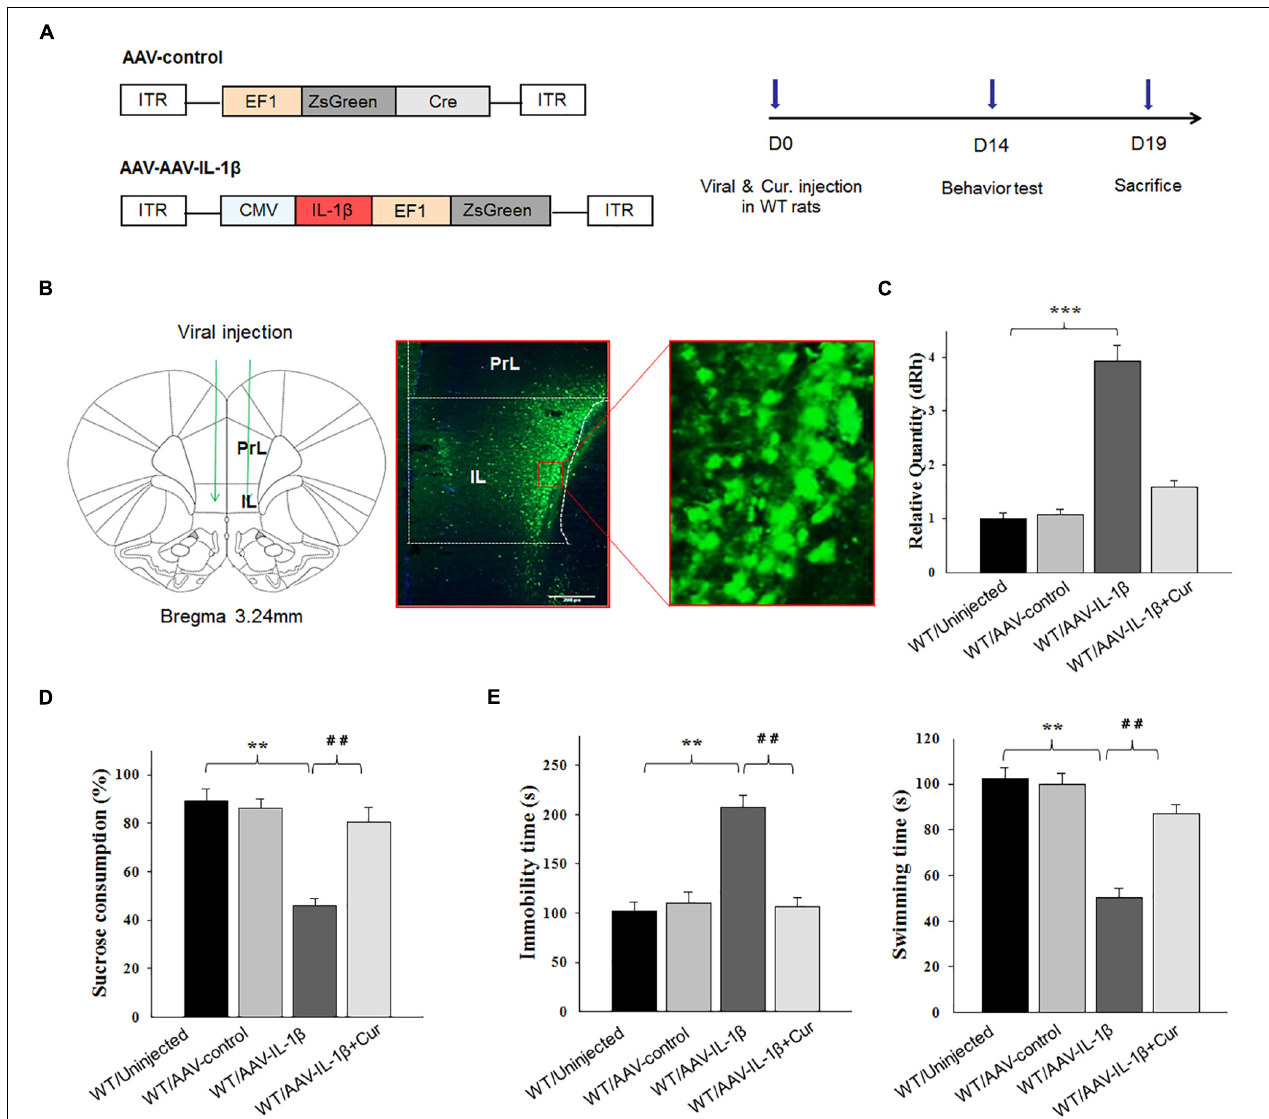
FIGURE 4 | Overexpression of IL-1 β within the vmPFC leads to depression-like phenotypes in normal wild type rats. (A) Left: Schematics of AAV vectors engineered to overexpress a control construct or IL-1 β . ITR, inverted terminal repeats; EF1, ZsGreen promoter; CMV, IL-1 β promoter. Right: Experimental paradigm for behavioral biochemical testing of rats infected with the virus. (B) Illustration of viral infusion of AAV-IL-1 β into the vmPFC. PrL, prelimbic cortex; IL, infralimbic cortex. Scale bar is 100 µ m. (C) Estimation of β CaMKII overexpression efficiency after viral constructs injection. (D,E) Behavioral effects of over expressing viral AAV-IL-1 β in the vmPFC. N = 12 in all groups. ∗ P < 0.05, ∗∗ P < 0.01, ∗∗∗ P < 0.001 WT + AAV-IL-1 β vs. WT rats. # P < 0.05, ## P < 0.01, ### P < 0.001 WT + AAV-IL-1 β + Cur vs. WT + AAV-IL-1 β (WT, wild type).